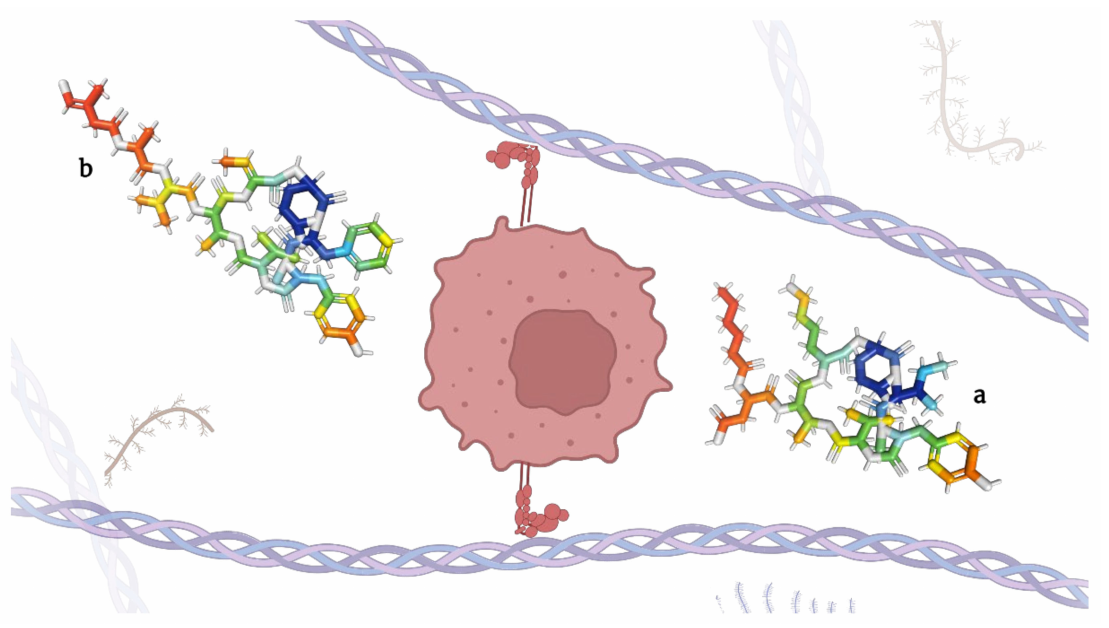
Figure 4. Micropeptins ( a ) and tutuilamides ( b ), depsipeptides capable of inhibiting